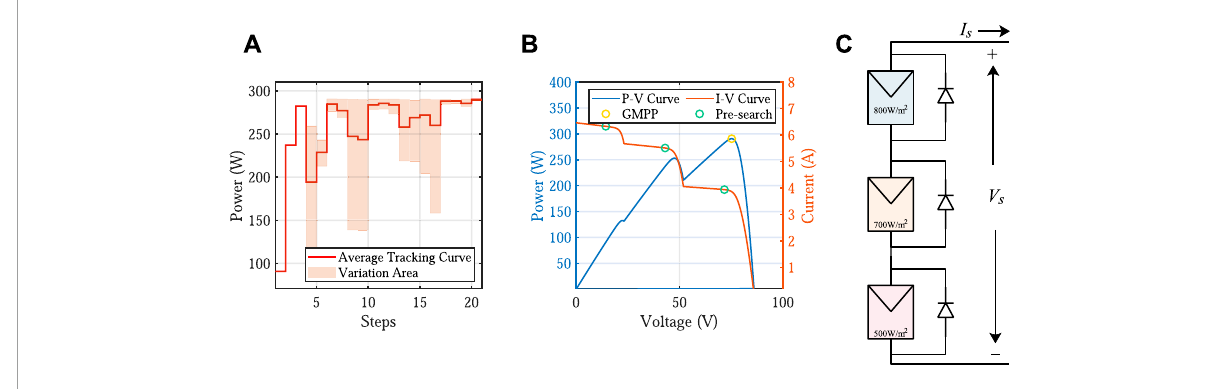
FIGURE 8 Average and best power curves under considered PSC test of a PV string with 3 PV modules: (A) Average tracking power curve and variation area; (B) P-V and I-V curve of the tested PSC; (C) The PV string topology.